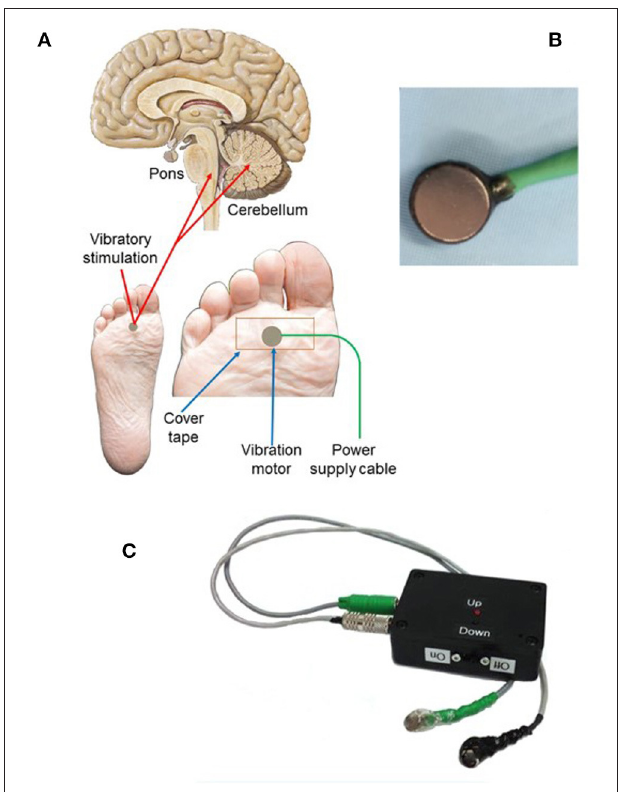
FIGURE 1 | Vibratory placement, brain targets, and stimulation components of limb proprioceptive device. (A) Placement of vibrator motor on the sole of the foot, using non-allergenic tape for adherence; power supply leads provide power to the vibratory motor at 3.0V. Central targets for vibration include the cerebellum and dorsal pons. (B) Vibrator motor with power leads. (C) Power supply containing two 1.5VAA batteries with two levels of vibratory stimulation (up = 3.0V; down = 1.5V; vibration was always at 3.0V in this study). Component sources and vibratory motor specifications are outlined in Supplementary Material .